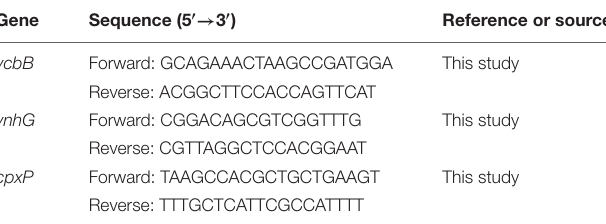
TABLE 2 | Primer sequences for qPCR.